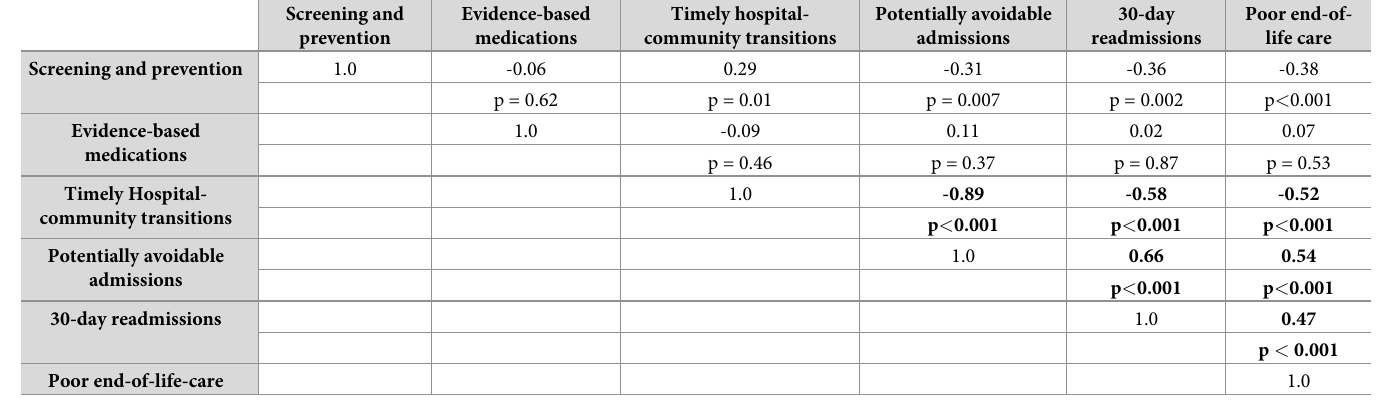
visits in the last 6 months of life, but moderate to high variability was seen in their receipt of chemotherapy, ED visits and intensive care unit stays. Correlation coefficients between the quality domain rates are reported in Table 2 and the relationships displayed in Fig 1. Many relationships were as expected such as strong associa- tions between rates of avoidable admissions, readmissions and poor EOL care. However, we also found that rates of timely hospital-community transitions were inversely associated with rates of admissions (r = -0.89), readmissions (r = -0.58) and poor EOL care (r = -0.52) (Table 2, Fig 1). Networks with higher rates of physician spending had lower rates of avoidable admissions; the strongest association, however, was with outpatient primary care physician spending (r = -0.83) (Table 3, Fig 2). Networks with higher outpatient primary care spending also had lower (Table 3, Figs 2 and 3). Networks with higher rates of timely hospital-community transitions had lower spending on prescription drugs and long-term care (r = -0.56 and -0.61, respec- tively). As expected, there were strong relationships between spending and hospital admission rates; however, we found little association between spending and rates of prescribing of evi- dence-based medications, and screening and prevention. Table 2. Correlations between quality domain